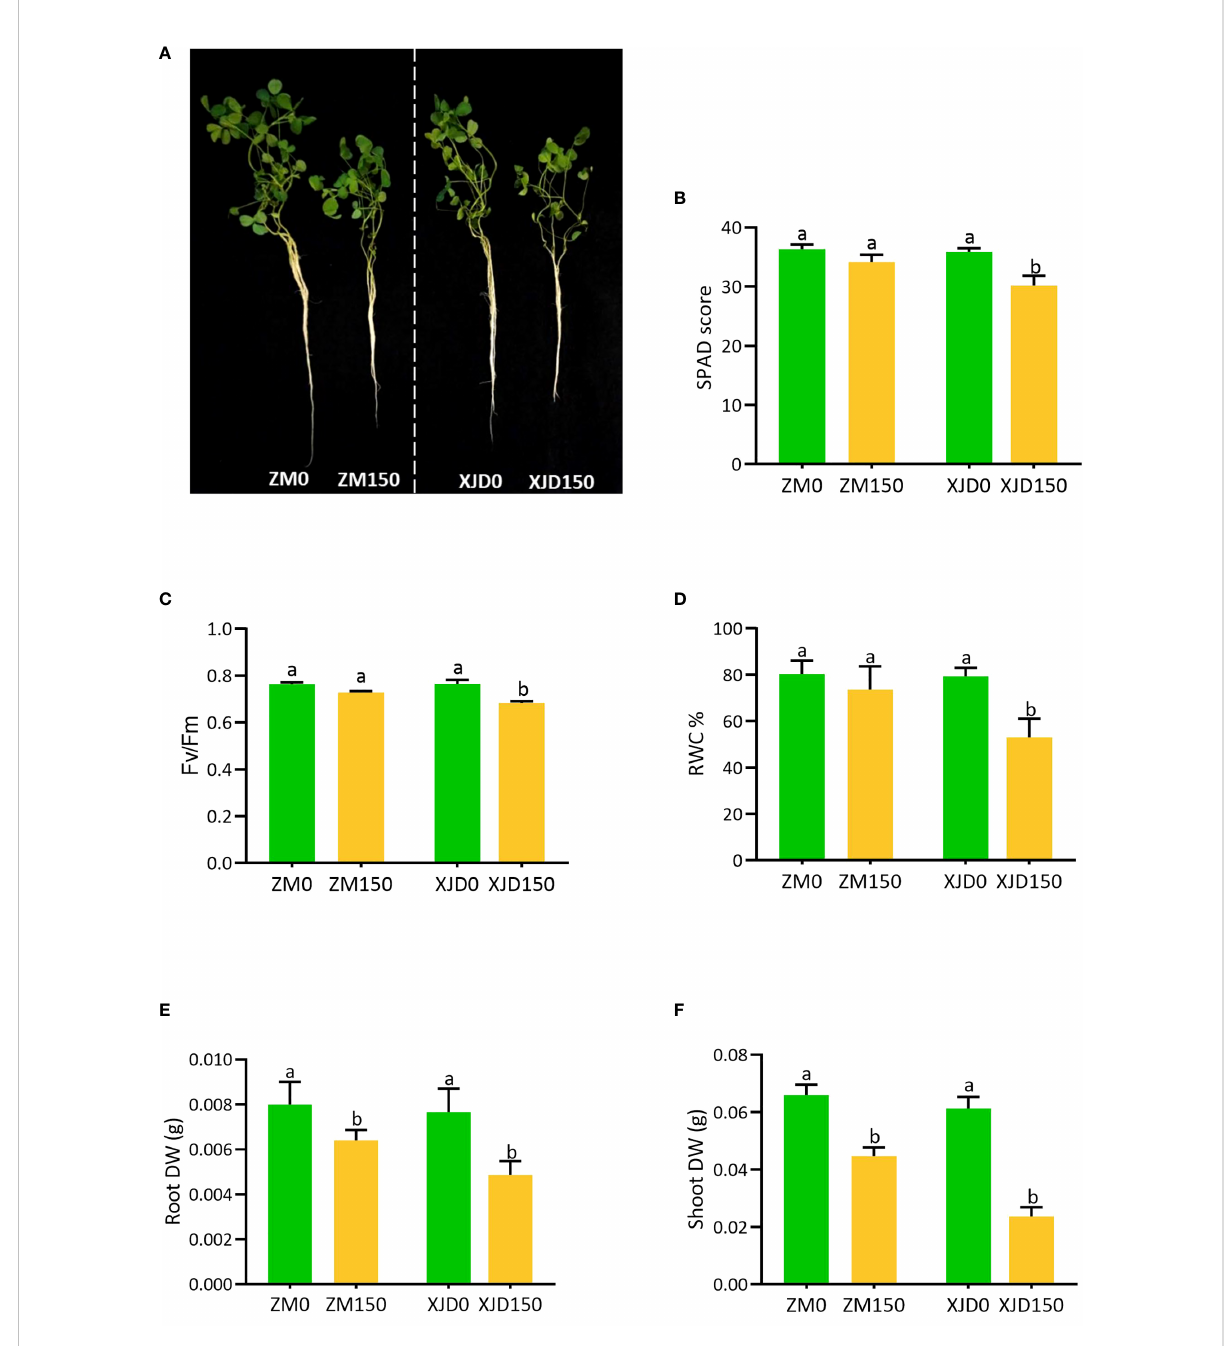
FIGURE 1 The variation of morphological and physiological indices in two contrasting alfalfa genotypes in response to salt stress. Different plant phenotypes (A) , SPAD score (B) , Fv/Fm (C) , RWC% (D) , Root DW (E) , and Shoot DW (F) , changes in Zhongmu (ZM) and Xingjiang Daye (XJD) under salt stress. The numeric zero (0) indicates salt-untreated (control) plant, while the numeric 150 indicates 150 mM salt treatment. Different letters above the column bar indicate signi fi cant differences among the means ± SD of treatments (n = 3). Data were analyzed by ANOVA and Tukey ’ s tests at p ≤ 0.05 signi fi cant